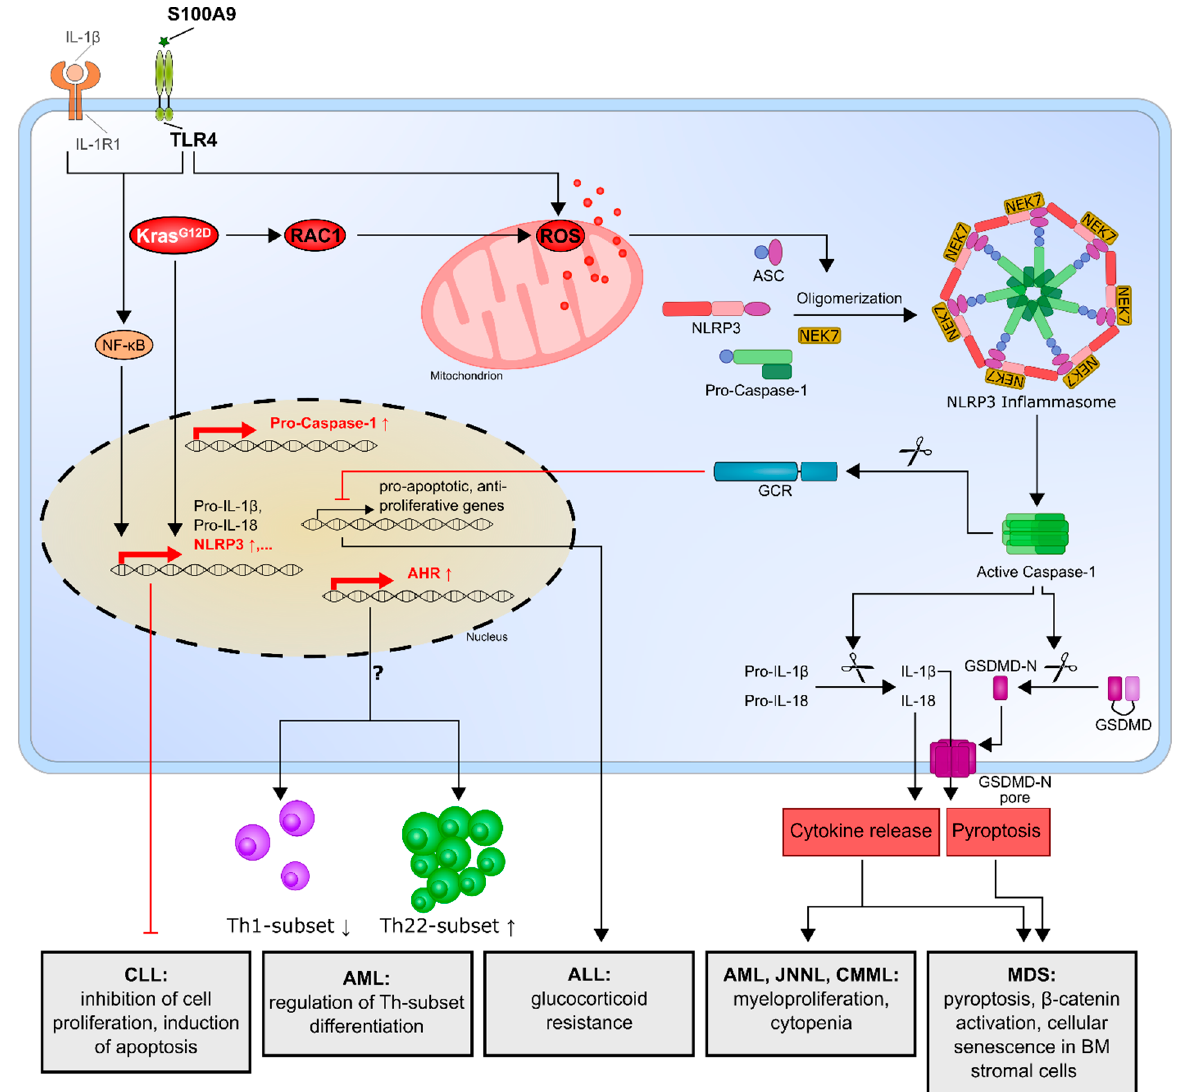
Figure 2. The NLRP3 inflammasome and its effects in leukemia. DAMPs such as alarmin S100A9 induce the transcriptional upregulation of inflammasome components mainly via activation of the transcription factor NF- κ B. DAMPs and/or MDS gene mutations lead to the production of ROS, which cause NLRP3 inflammasome activation and, consequently, pyroptotic cell death and altered inflammatory cytokine secretion in MDS patients. In CMML, JNNL and AML, the oncogenic Kras G12D mutation leads to NLRP3/ASC transcription and ROS production via the activation of RAC. Elevated NLRP3 and caspase-1 expression in ALL results in caspase-1-mediated cleavage of the glucocorticoid receptor. Enhanced NLRP3 expression in AML patients correlates with an increased expression of AHR and a shift in Th cell subsets, while NLRP3 overexpression inhibits cell proliferation and induces apoptotic cell death in CLL. ↓ = Activation; ⊥ = Inhibition. NLRP3, NOD-like receptor protein 3; ASC, apoptosis-associated speck-like protein; NEK7, NIMA-related kinase 7; GSDMD, Gasdermin-D; GSDMD-N, GSDMD amino-terminal cell death domain; DAMP, damage-associated molecular pattern; NF- κ B, nuclear factor- κ B; CLL, chronic lymphocytic leukemia; AML, acute myeloid leukemia; AHR, aryl hydrocarbon receptor; Th subset, T-helper cell subset; ALL, acute lymphocytic leukemia; CMML, chronic myelomonocytic leukemia; JNNL, juvenile myelomonocytic leukemia; RAC, Ras-related C3 botulinum toxin substrate 1; ROS, reactive oxygen species; IL-1 β , interleukin-1 β ; MDS, myelodysplastic syndrome and S100A9, S100 calcium-binding protein A9.